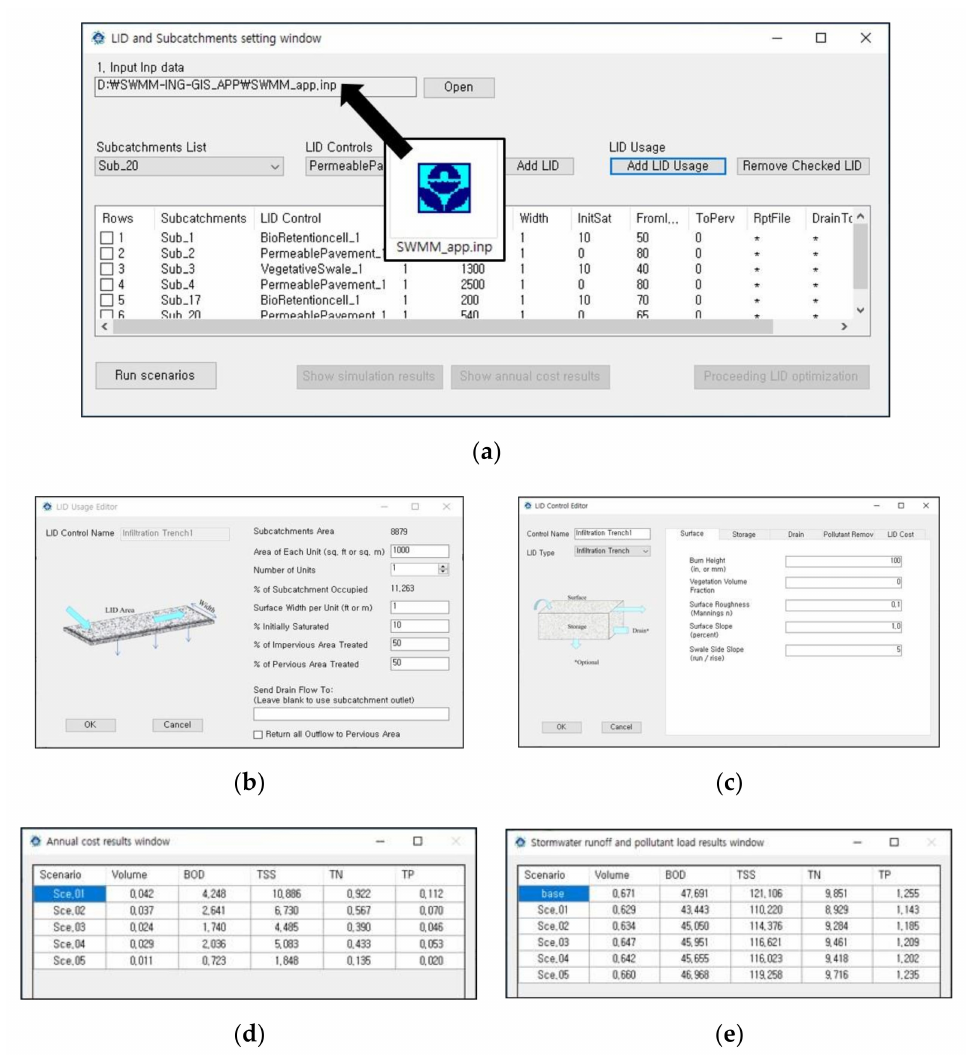
Figure 7. SWMM interfaces for LID definition: ( a ) LID and Sub-catchments setting window; ( b ) LID Control Editor window; ( c ) LID Usage Editor window; ( d ) Stormwater runo ff and pollutant load result window; ( e ) Annual cost results